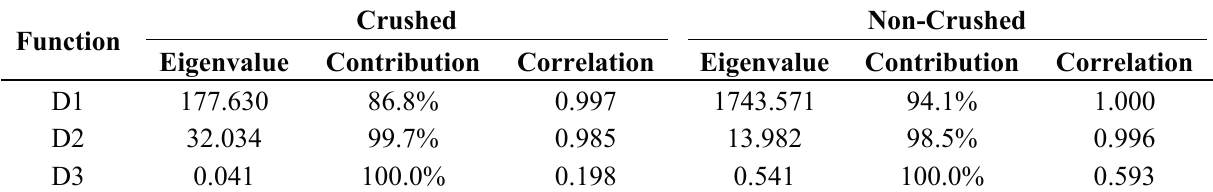
Figure 5. Discrimination of rice sample solutions by employing DFA analysis. ( a ) Crushed rice; ( b ) Non-crushed rice. ( Ο ) XiuShui134, (*) XiuShui128, ( ⊿ ) JiaHe218, and ( Δ ) JiaHe66, also the centroid of each class is plotted (+). Table 3. Classical discriminant analysis results for rice